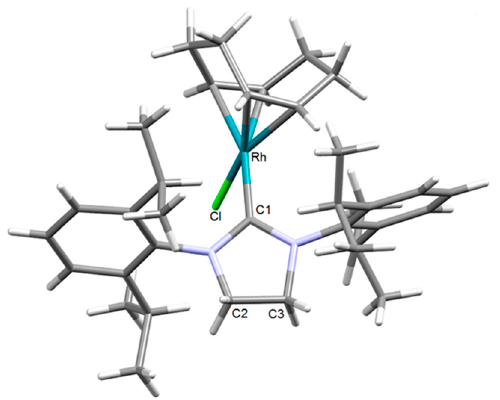
Figure 4. Capped sticks representation of the solid-state structure of [RhCl(cod)(SIPr)]_benzene_ 4 (benzene molecules are omitted for clarity).